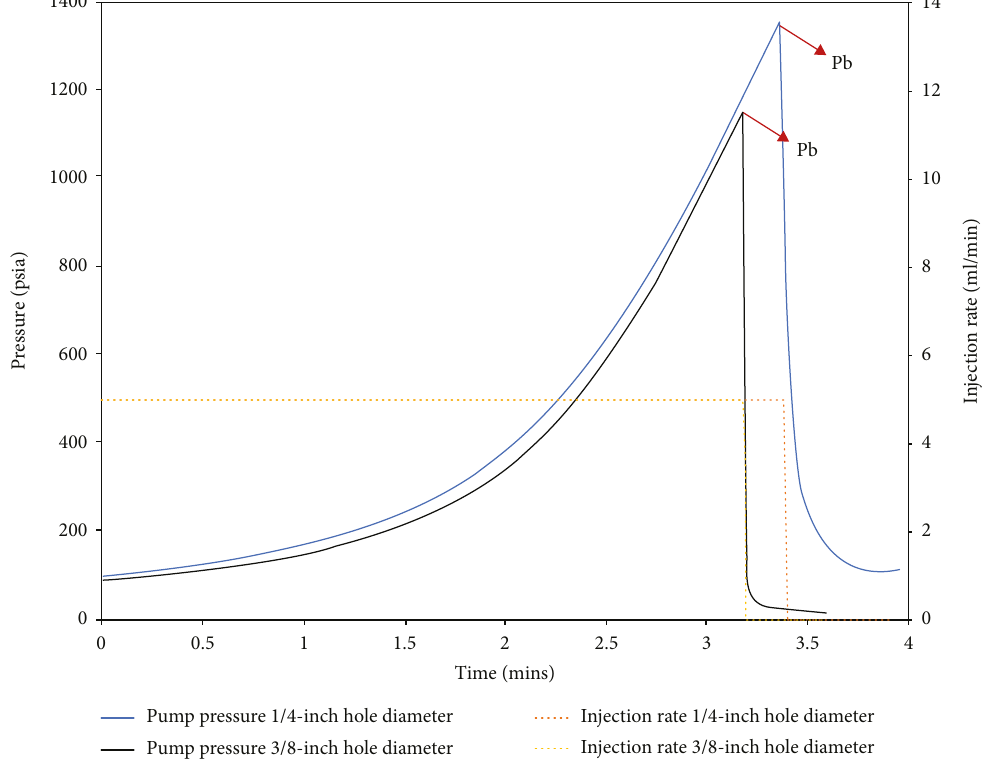
Figure 10: Injection pressure and injection rate pro fi les with time for the conventional hydraulic fracturing experiment with water on 1/4- inch and 3/8-inch hole diameter